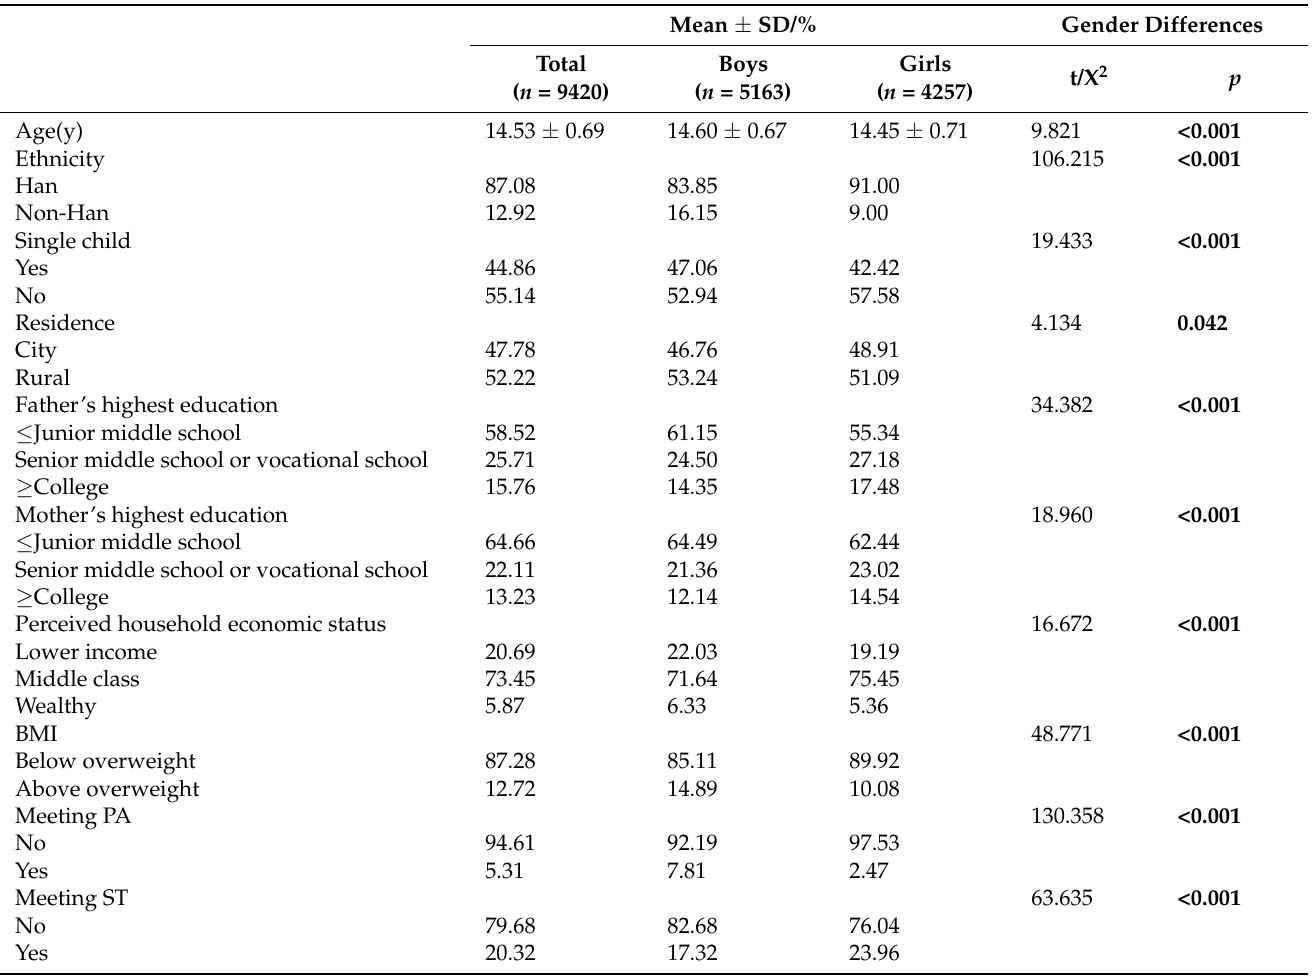
Table 2. Characteristics of Chinese